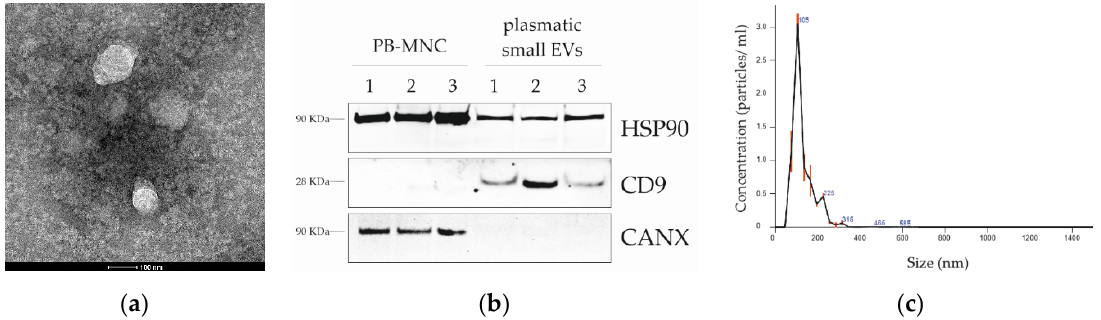
Figure 1. ALCL plasmatic small extracellular vesicle (S-EV) characterization. ( a ) Transmission electron microscopy analysis of plasmatic S-EVs from a representative ALCL sample. ( b ) Western blotting analysis of peripheral blood mononuclear cells (PB-MNCs) and representative ALCL plasmatic S-EVs, showing the presence of heat shock protein 90-kDa (HSP90) protein in both whole cells and S-EV lysates, exosome-specific tetraspanin CD9 in S-EV lysates only and the endoplasmic reticulum marker Calnexin (CANX) in total lysates, but not in S-EVs. ( c ) Size distribution of particle diameters (nm) of vesicles isolated from a representative ALCL plasma sample, as measured by nanoparticle tracking analysis (Nanosight, Malvern Panalytical).